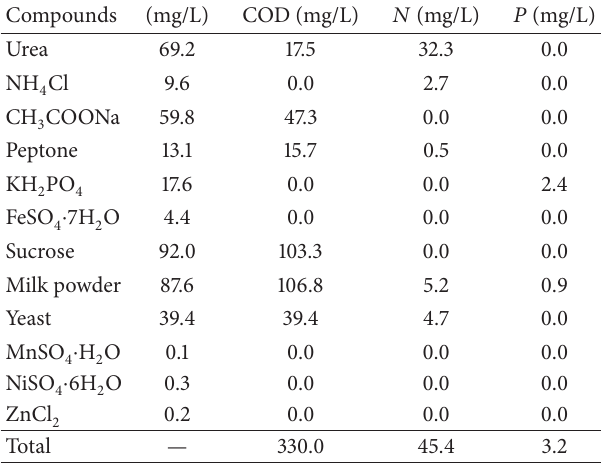
Table 1: SW2 synthetic wastewater composition. Compounds’ mixtures were dry-stored in 50mL sterile Falcon tubes until use, when they were dissolved into the proper amount of distilled water and then fed to the cell. Trace metals solution was added